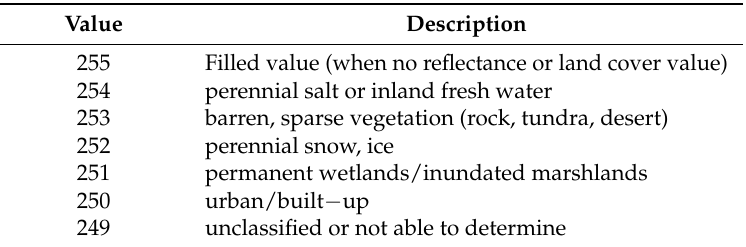
Table 2. LAI Fill value legend